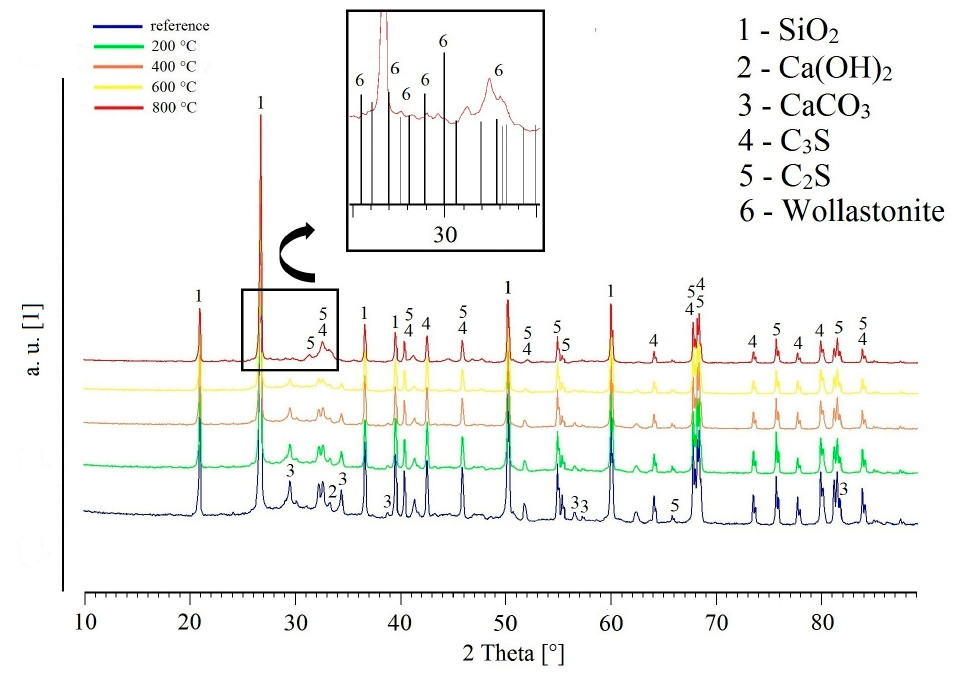
Figure 11. XRD patterns of UHPC samples after exposure to elevated temperatures.